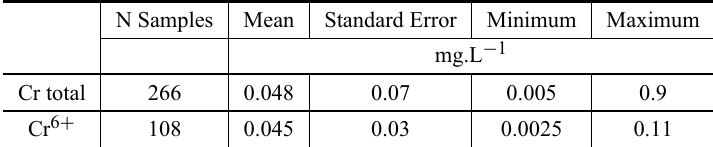
Concentrations of chromium detected in 144 wells from 1977 to 1993 (Almodovar and Pacheco